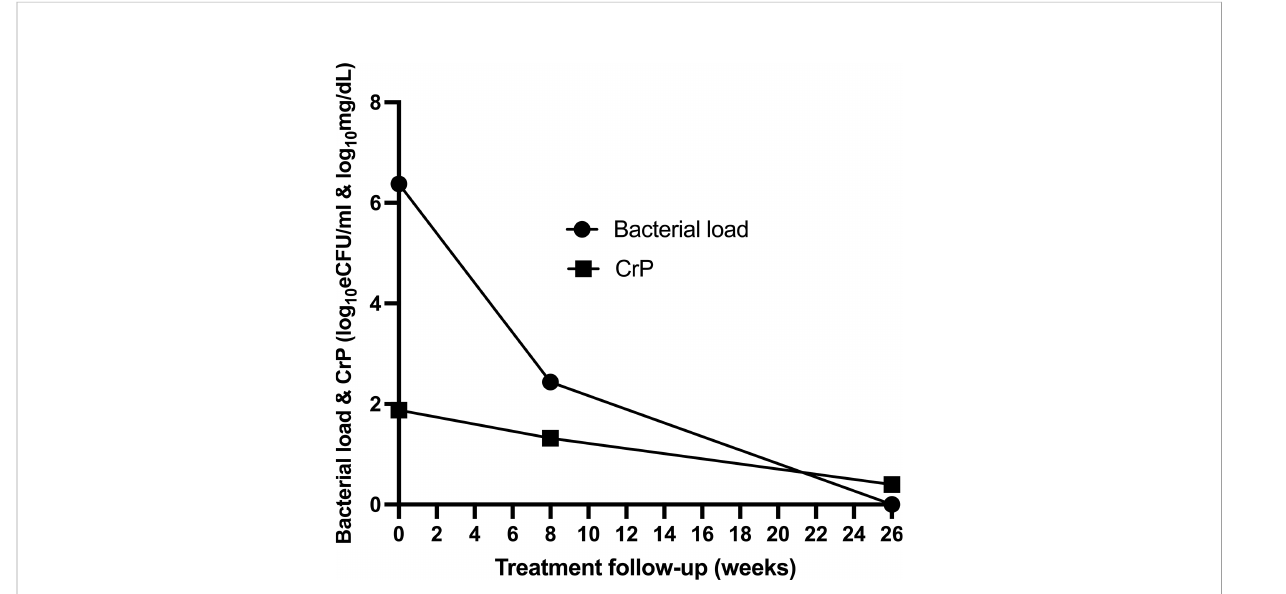
FIGURE 5 Comparison of the rate of resolution of bacillary load compared to CRP of 43 patients during anti-tuberculosis